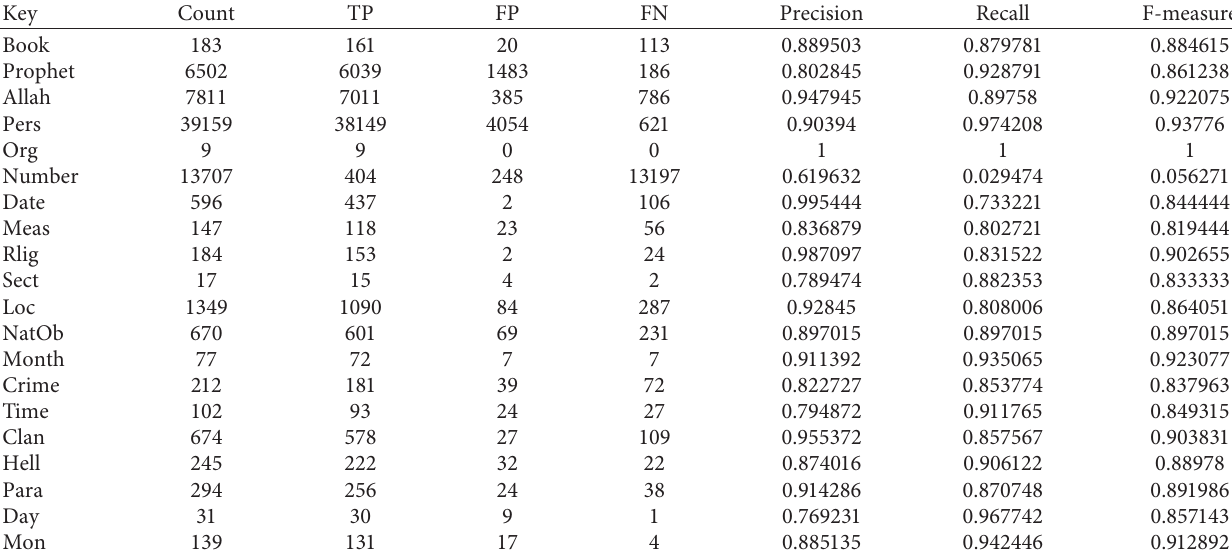
Table 13: Results of not using patterns.